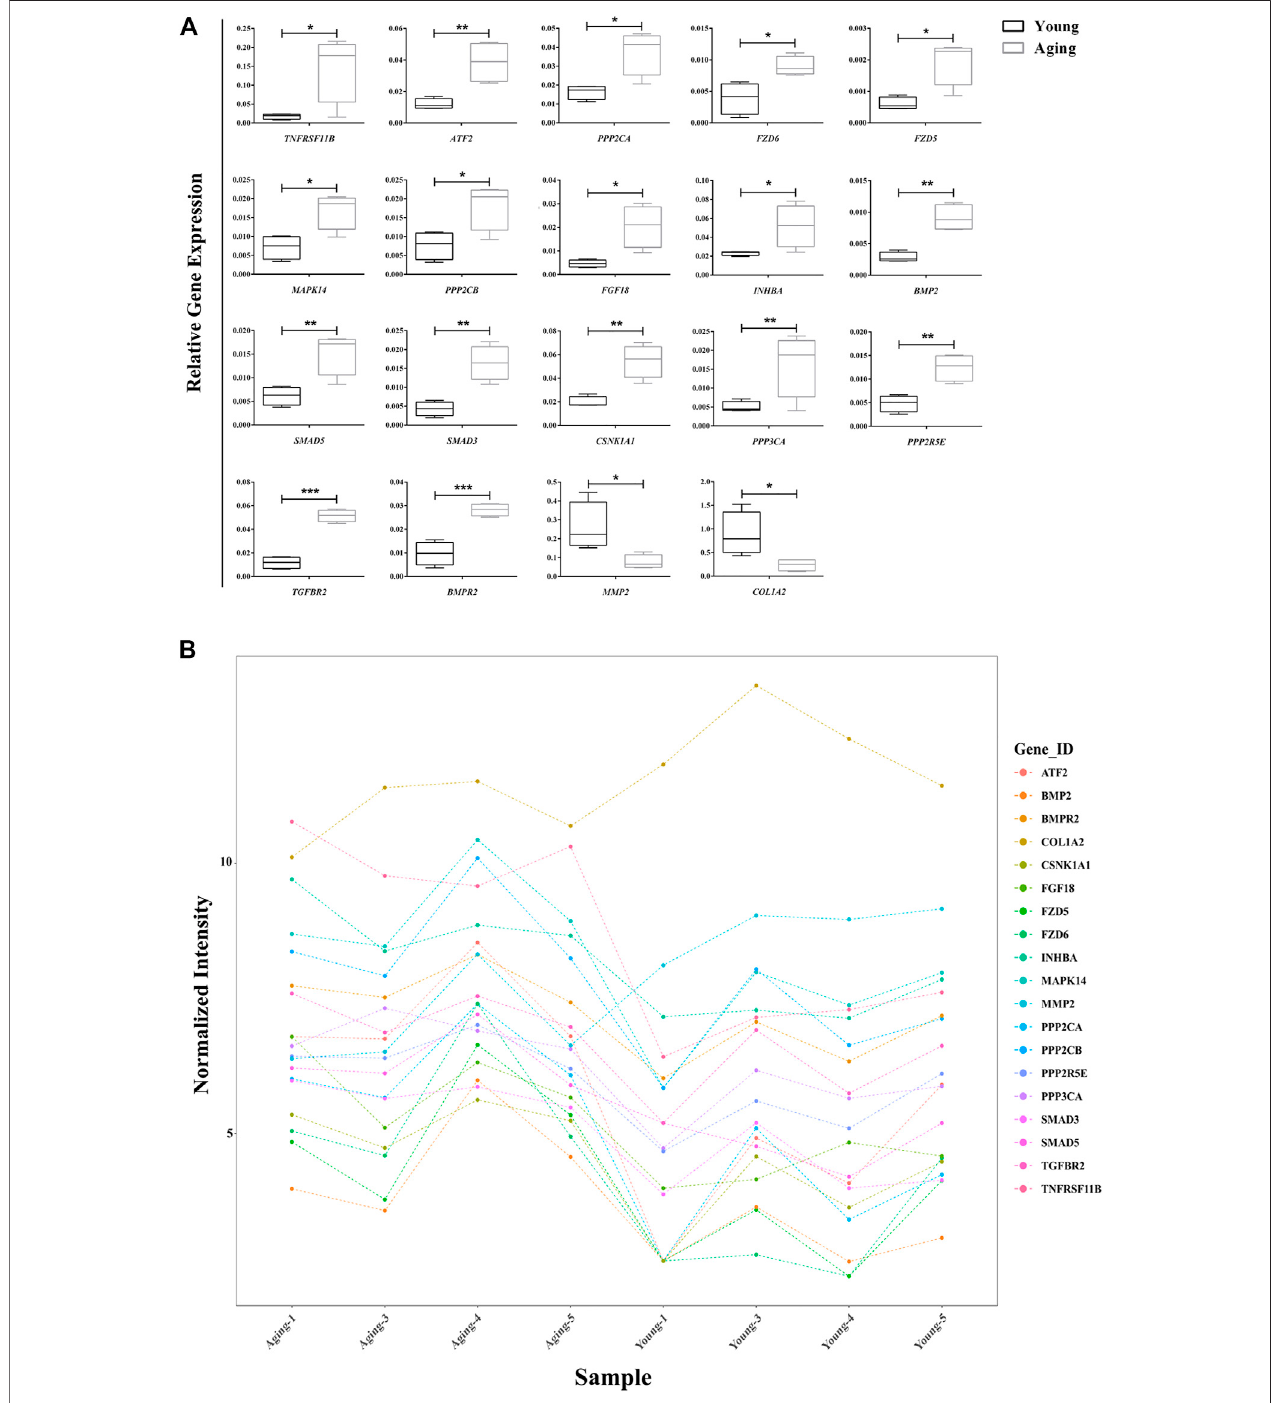
FIGURE 4 | Relative expression of target DE mRNAs. (A) Relative expression of 19 DE mRNAs were con fi rmed using qRT-PCR.; (B) Relative expression of 19 DE mRNAs in microarry analysis. * p < 0.05; ** p < 0.01, *** p < 0.001 vs. control, n = 5/group. DE, differentially expressed.